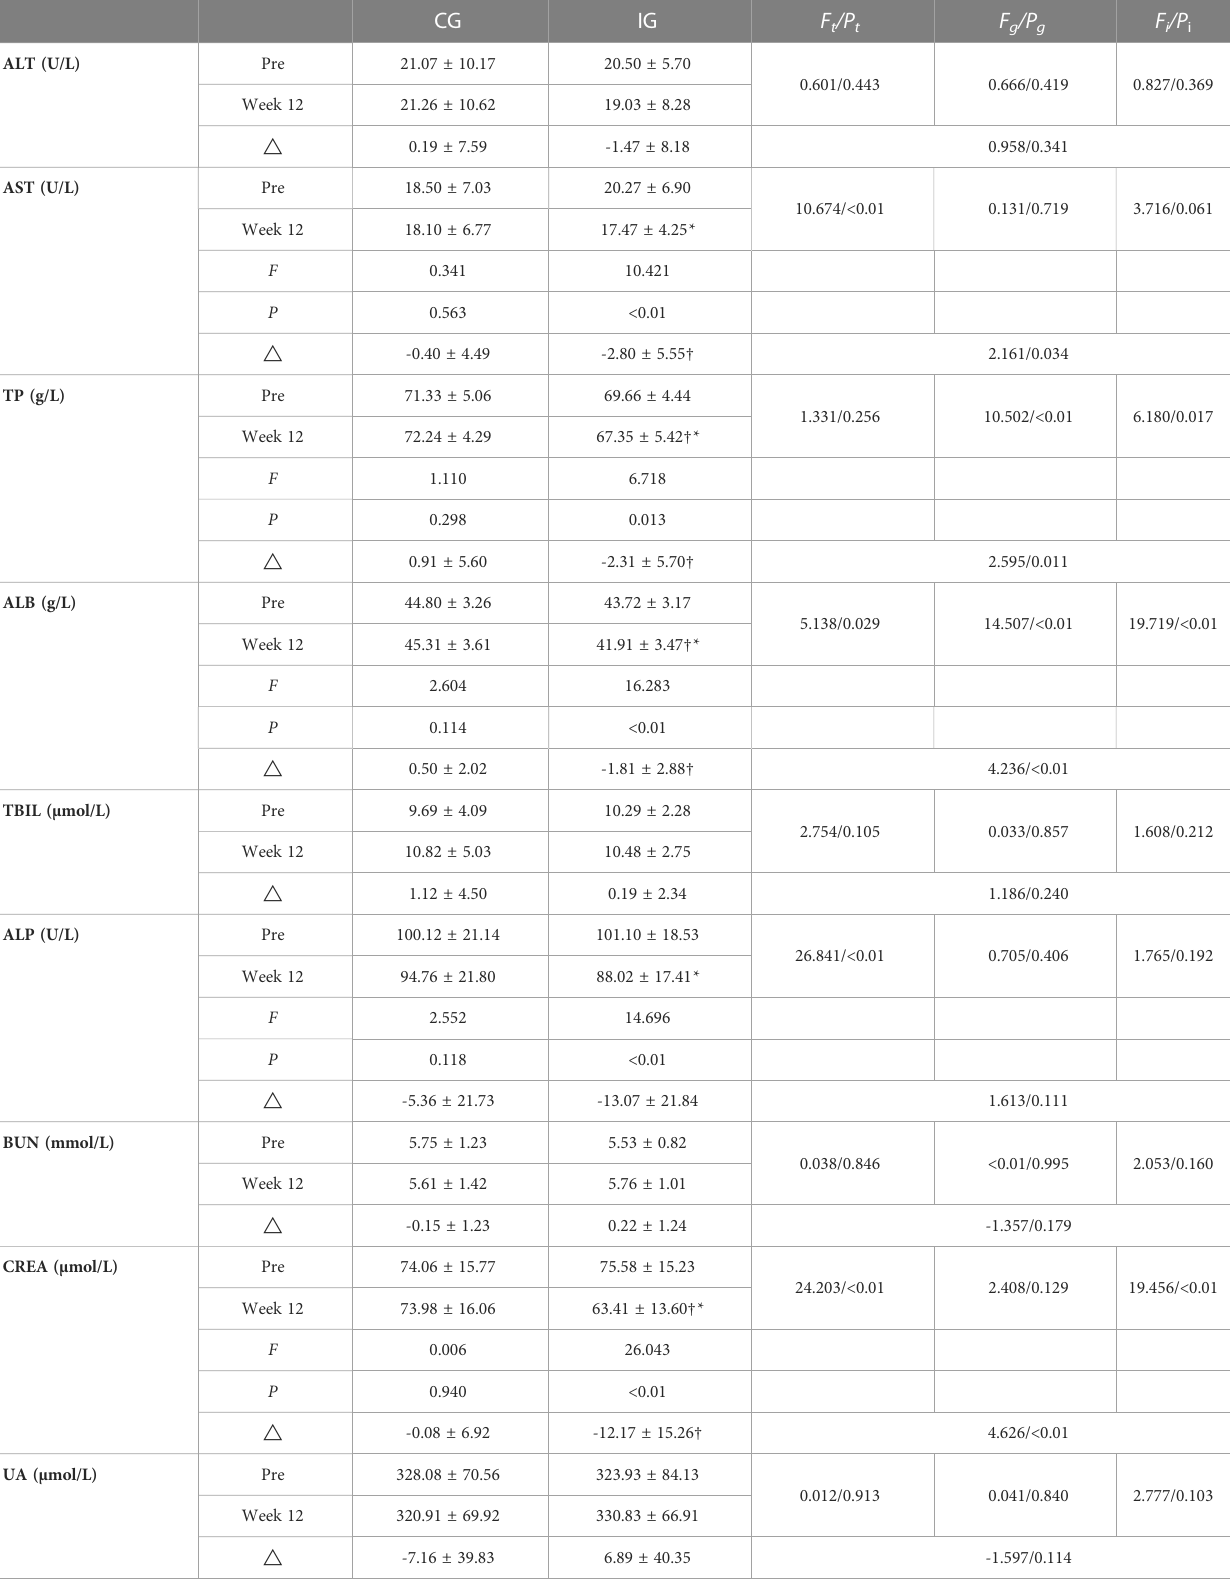
TABLE 5 Changes in hepatorenal levels in two groups (mean ±